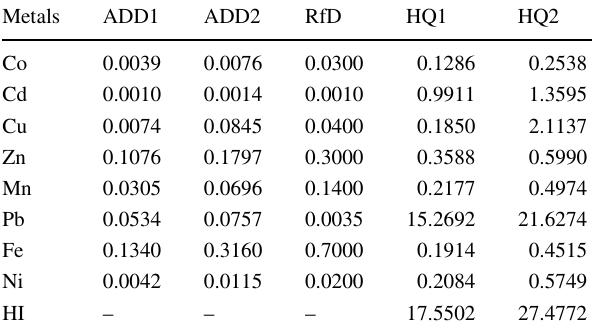
Table 8 ADD and HQ for studied benthic fauna